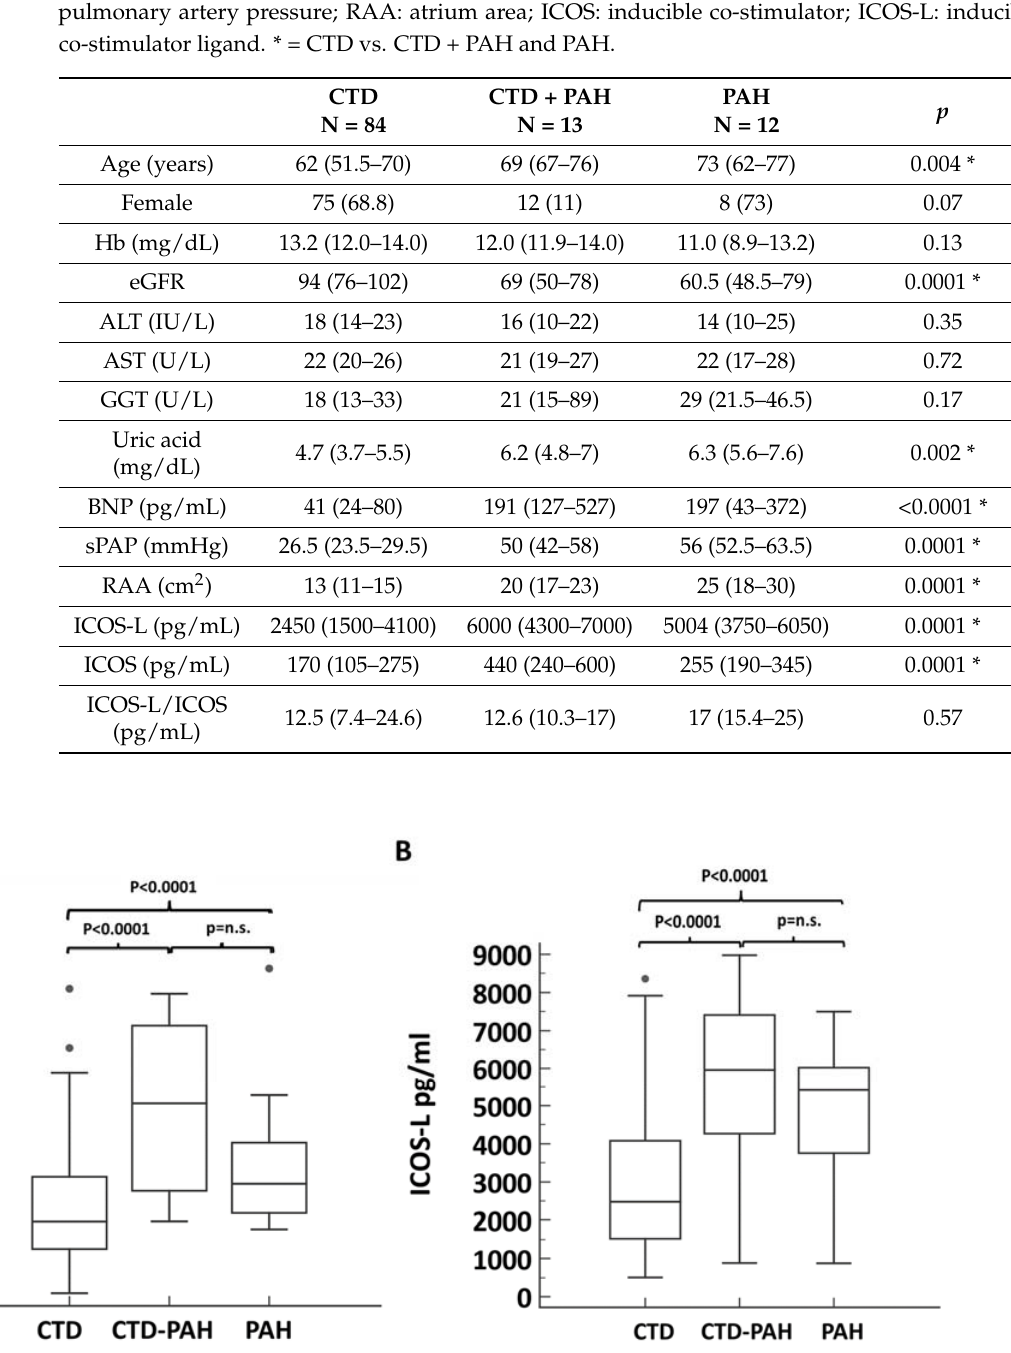
Table 2. Multivariate analysis of variables associated with PH. The table shows two multivariate analyses investigating the association of ICOS and ICOS ‐ L with the diagnosis of PH. Abbreviations: eGFR: estimated glomerular filtration rate; ICOS: inducible co ‐ stimulator; ICOS ‐ L: inducible co ‐ stimulator ligand. Variable